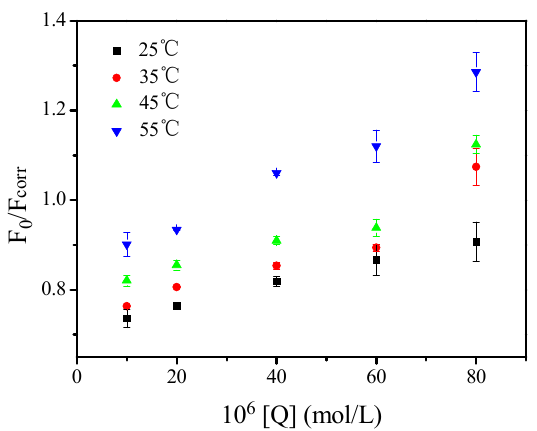
Figure 6. Stern − Volmer plots for the system of C-dots − dopamine at 25, 35, 45, and 55 ◦ C, respectively. F 0 and F corr are the fluorescence intensity of C-dots in the absence and presence of dopamine (DA), where F corr is the corrected fluorescence value. Conditions: C-dots, 800 µ L; PB, 30 mM, pH 8.0.